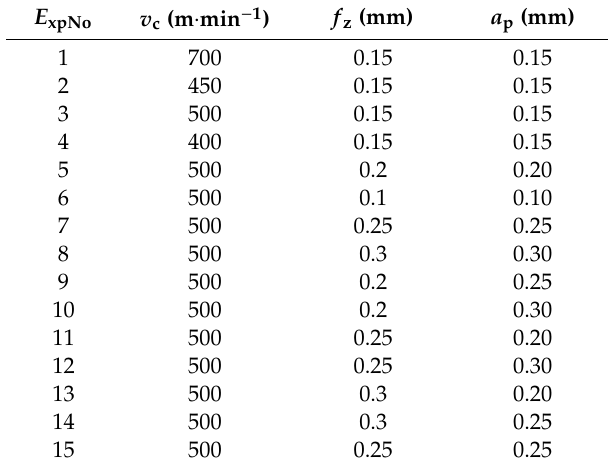
Table 3. Basic cutting parameters: the speed of cut v c , the feed per tooth f z , the depth of cut a p . E xpNo v c (m · min − 1 ) f z (mm)